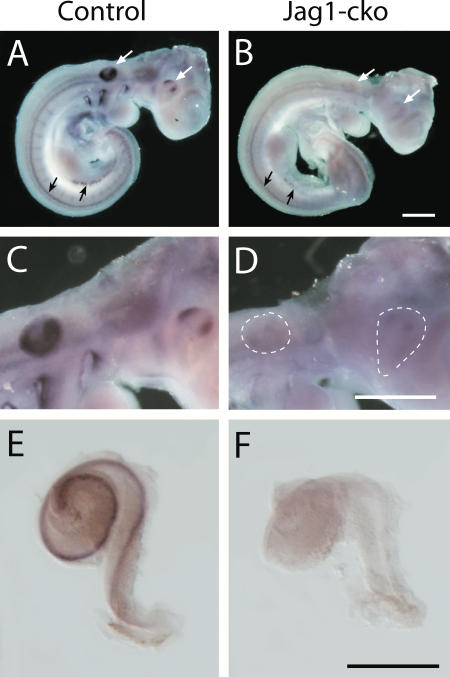
Conditional Jag1 Inactivation Using the Foxg1-Cre Line(A–D) Low- and high-power views of E10 embryos processed for whole-mount in situ hybridization using a Jag1 exon 4-specific probe. White arrows (A) point to the Jag1 signal in the otocyst (left arrow) and the eye (right arrow), two structures where Cre recombinase is expressed. In Jag1-cko mutants at E10, this signal is either absent or extremely weak. Black arrows (A and B) point to expression in the spinal cord and nephric duct, regions where Cre recombinase expression has not been reported in Foxg1-Cre mice. However, expression is consistently weaker in these areas in Jag1-cko embryos, indicating that there may be low levels of widespread expression of Cre recombinase in Jag1-cko embryos. In (D), the otocyst and the eye are outlined by a dotted line. Very little expression is observed in these regions, consistent with Foxg1-Cre expression.(E and F) In situ hybridization of E16.5 cochleae demonstrating Jag1 expression in wild-type (E) and Jag1-cko cochleae (F), where expression is entirely absent. Scale bars = 500 μm.